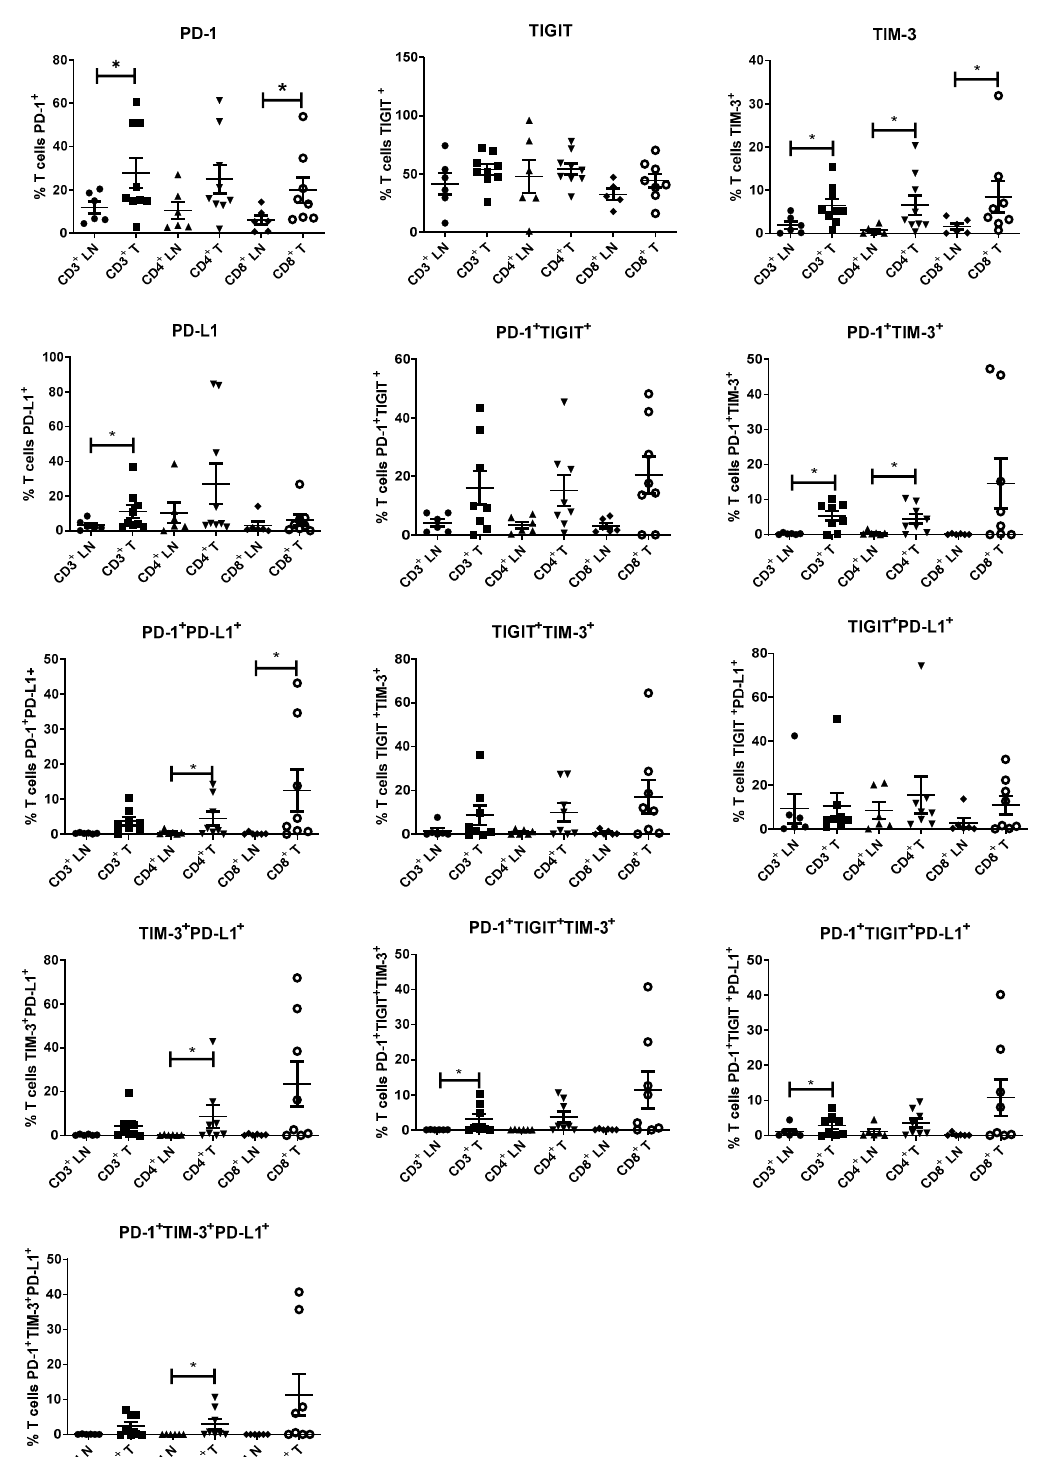
Figure 5. Inhibitory IC receptors and ligands are expressed at significantly higher levels on tumour-infiltrating T cells compared to T cells present in tumour-draining lymph nodes. CD3 + , CD3 + CD4 + , CD3 + CD8 + cells in tumour-draining lymph nodes ( n = 6) and infiltrating tumour tissues ( n = 6) in OAC patients were screened for the surface expression of PD-1 + , TIGIT + , TIM-3 + and PD-L1 + ex vivo by flow cytometric analysis. Tumour draining lymph nodes and tumour specimens were post-treatment and taken at surgical resection. Wilcoxon rank test was used to compare expression between lymph node and tumour compartment; * p < 0.05. LN: lymph node and T: